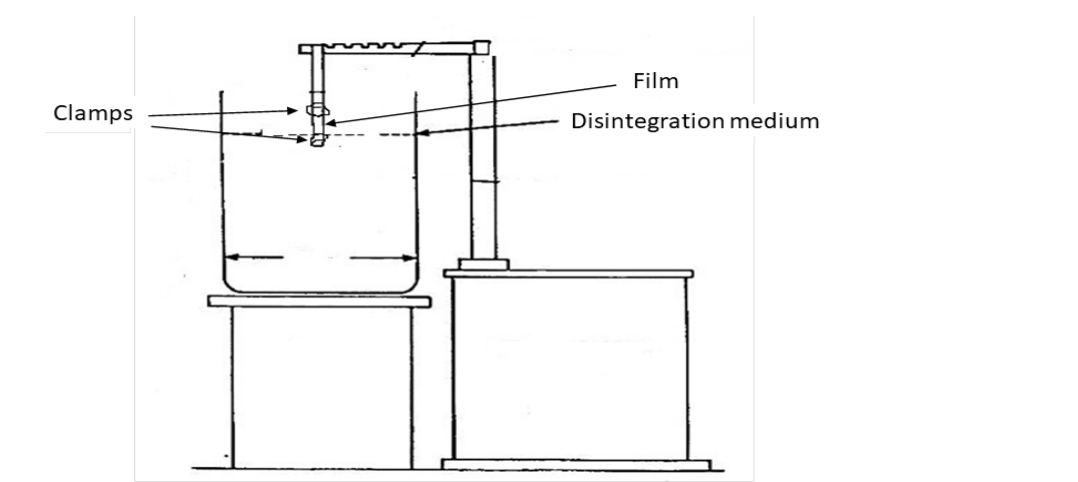
FIGURE 1 - Schematic diagram of the modified in-vitro disintegration apparatus.